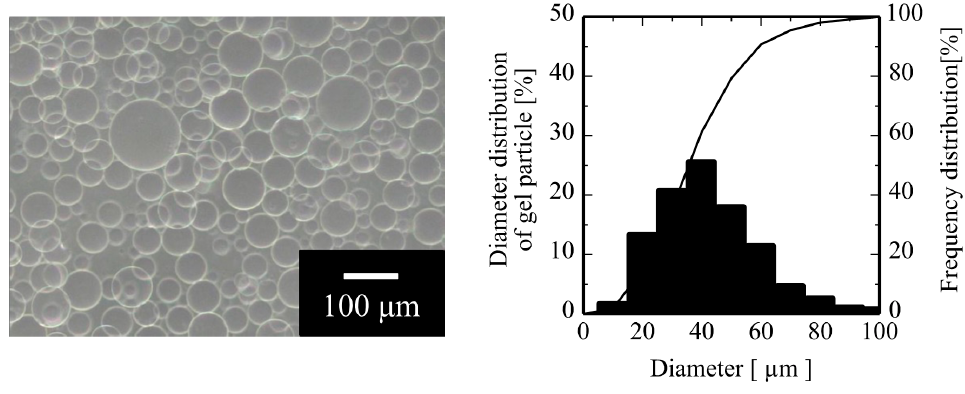
Figure 2. Optical microscope image and size distribution of the obtained gel (150× magnification).